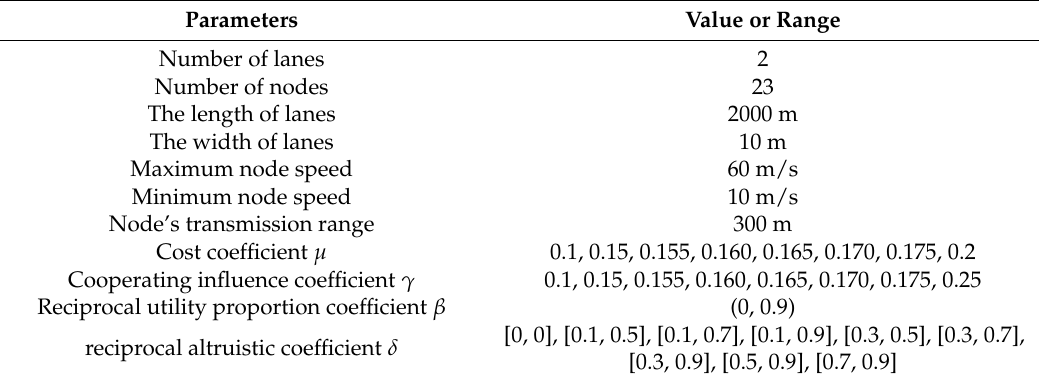
Table 3. Simulation